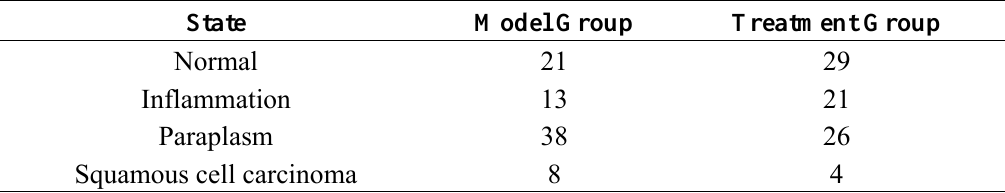
Table 5. Different histologic incidences in model and treatment groups.